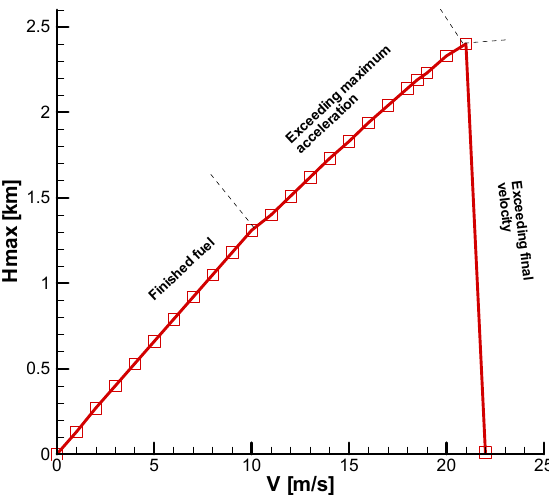
Figure 26. Maximum altitude for vertical evolution—first scenario.